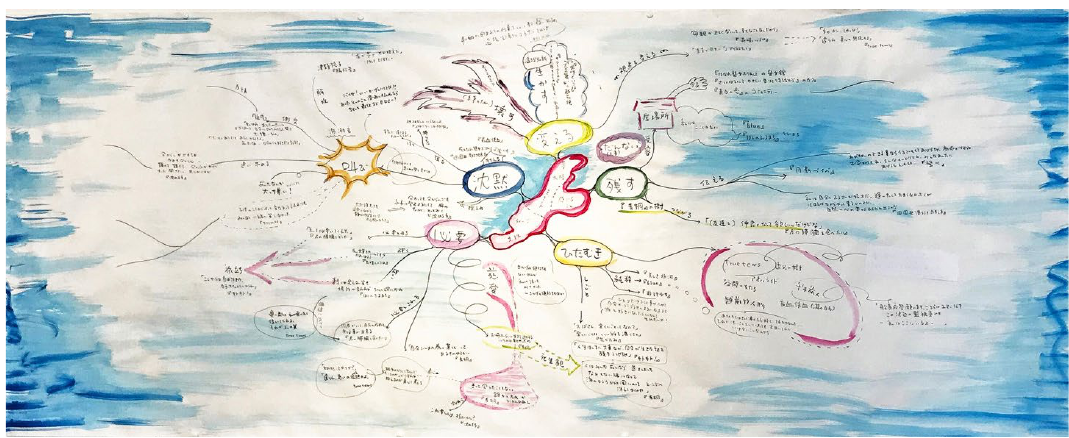
Figure 33 Narrative collage out of Hokuriku media made in the workshop coordinated by Tomko Shoji.